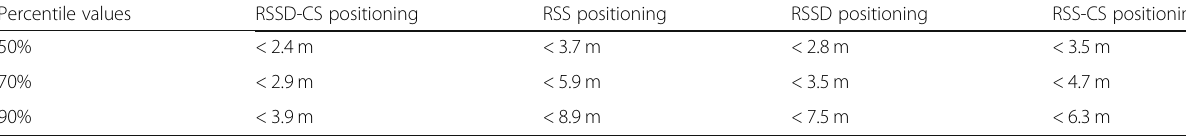
Table 2 Different percentile values concerning the positioning error under terminal heterogeneous Percentile